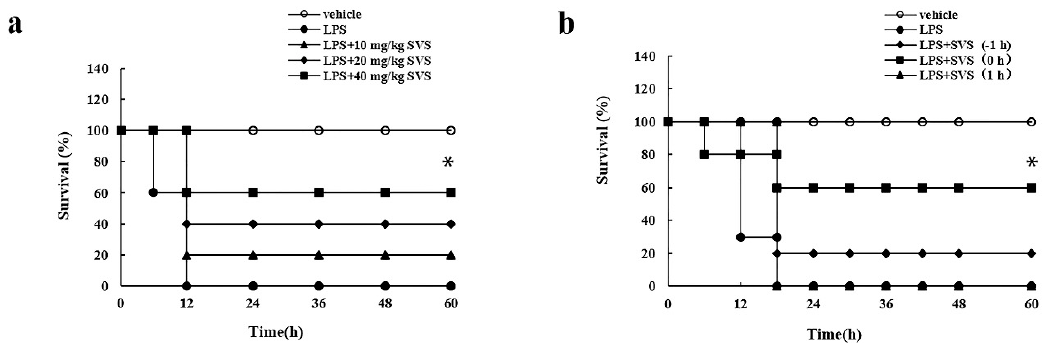
Figure 9. The in vivo effects of stevioside in a mouse model of LPS-induced excessive cytokine-mediated lethal shock. ( a ) Dose-dependent effect of stevioside on survival of mice with lethal shock ( n = 10); ( b ) Time-dependent effect of stevioside on survival of mice with lethal shock ( n = 10). * p < 0.05 versus LPS-treated group. SVS, stevioside.